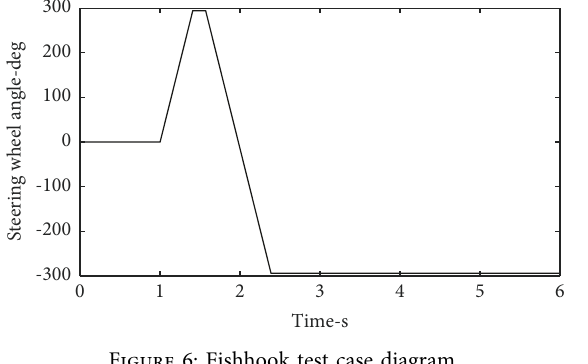
Figure 6: Fishhook test case diagram.